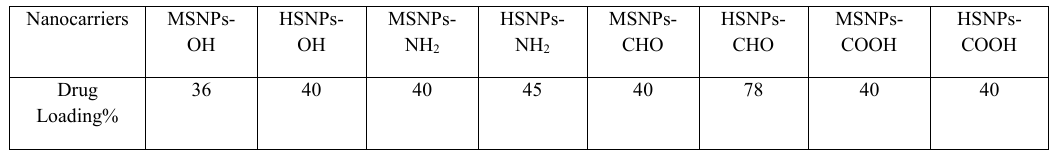
Fig. 5. EDX spectra of (a) HSNPs-OH, (b) HSNPs-NH Table 1. The loading percentages of